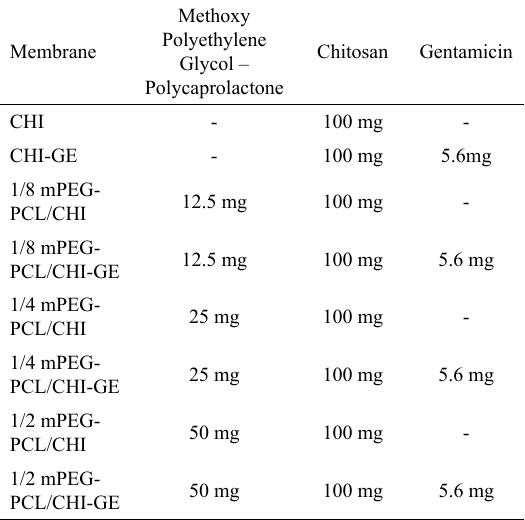
Table 1. Composition of membranes